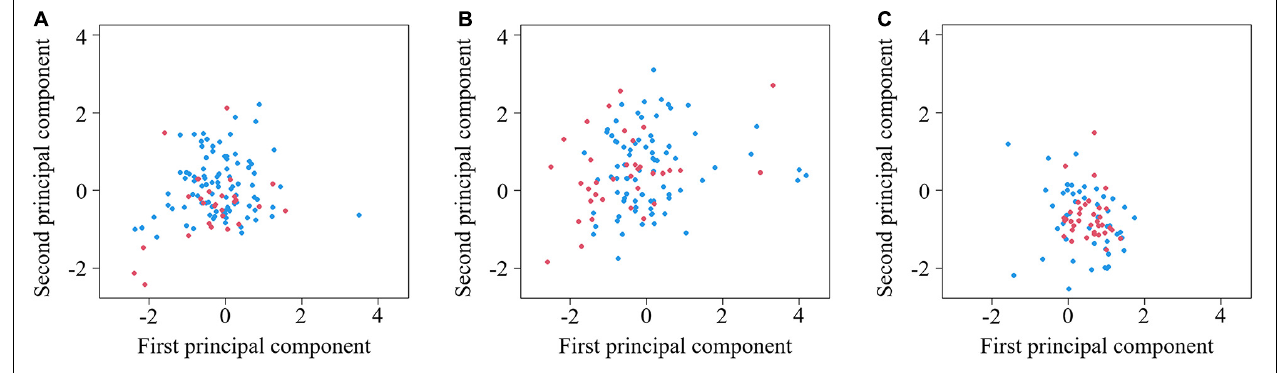
FIGURE 3 | Female common cuckoo “bubbling” calls highly overlapped between different periods in Liaohe Delta Nature Reserve (A) , Wild Duck Lake (B) , and Dagangzi National Forest (C) . The blue points indicate calls recorded before 12:00; the red points indicate calls recorded after